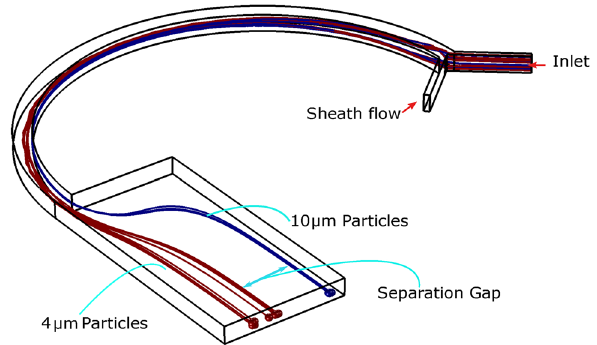
Figure 4. Simulation results on the primary geometry with a single contracted curved and expanded low aspect ratio AR architecture. Model Particles with sizes 4 and 10 µm were injected with the sheath flow. Simulation shows separation of the particles with visible separation gap.